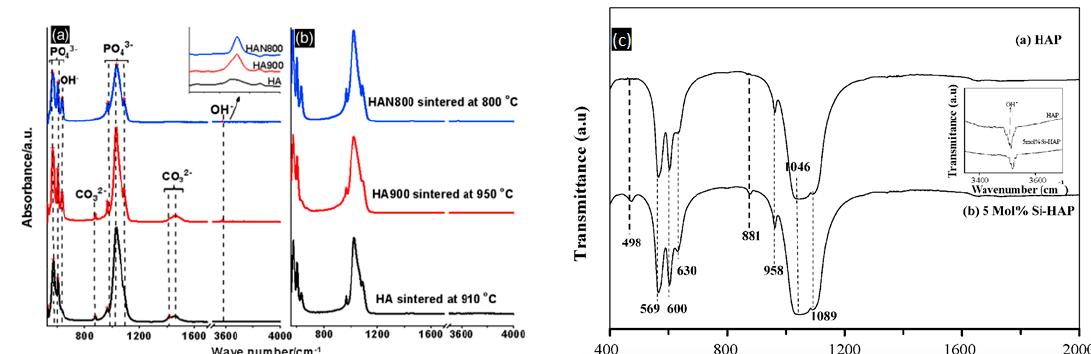
Figure 1. ( a ) FTIR spectra of HAP. Reproduced with permission from [30], Elsevier, 2014. ( b ) FTIR spectra of Si-substituted HAP. Reproduced with permission from [31], Elsevier, 2008. ( c ) FT-IR spectra of (a) pure HAP and (b) 5mol% Si-substituted